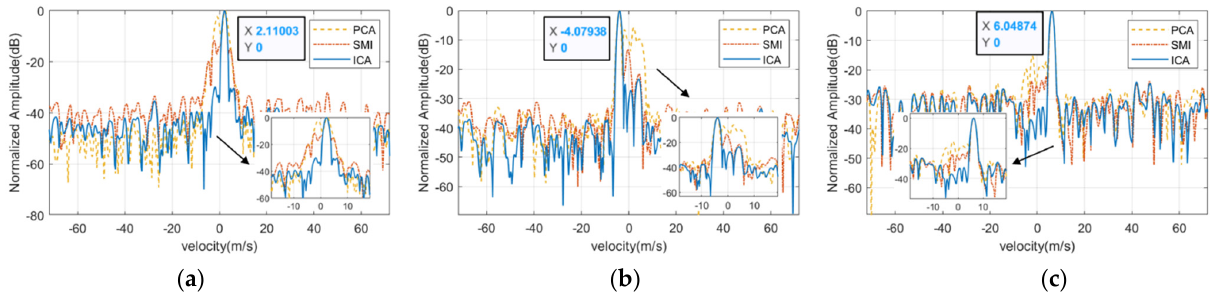
Figure 7. The three separated targets after st − MIMO − ICA processing together with the results of the other two approaches: ( a ) Target 1 ′ s velocity spectrum; ( b ) Target 2 ′ s velocity spectrum; ( c ) Target 3 ′ s velocity spectrum.